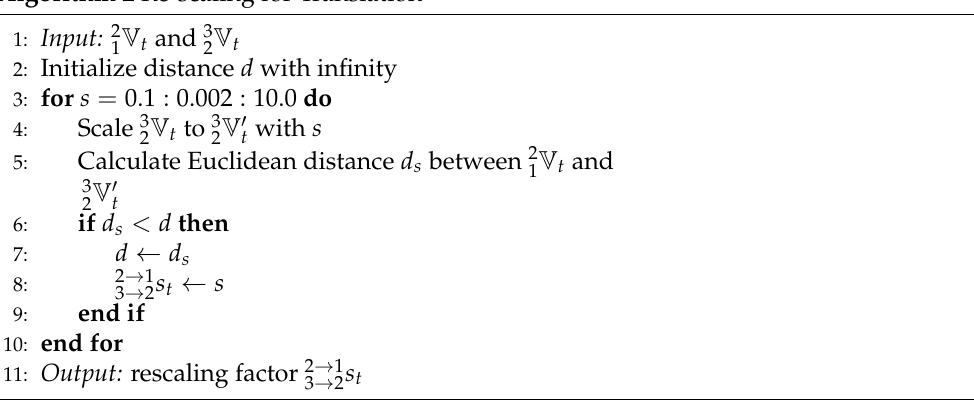
Algorithm 2 Re-scaling for Translation